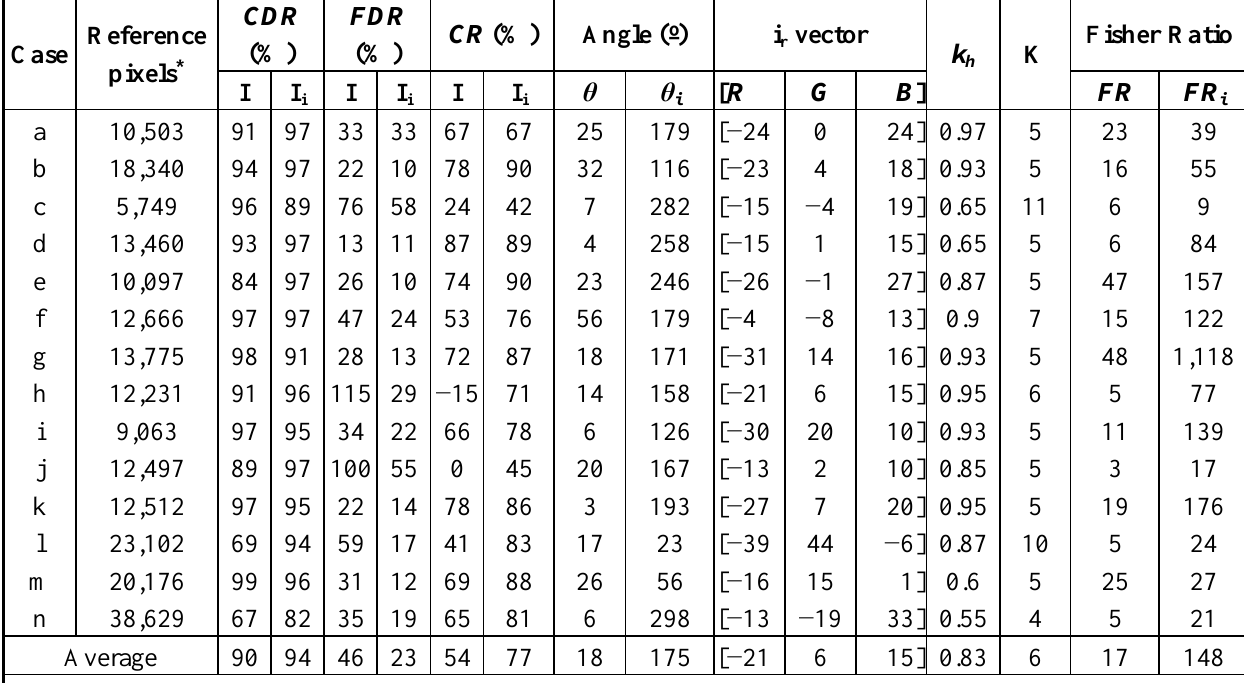
Table 2. Comparative analysis of the segmentations for the 14 example images shown in Figure 15, without noise